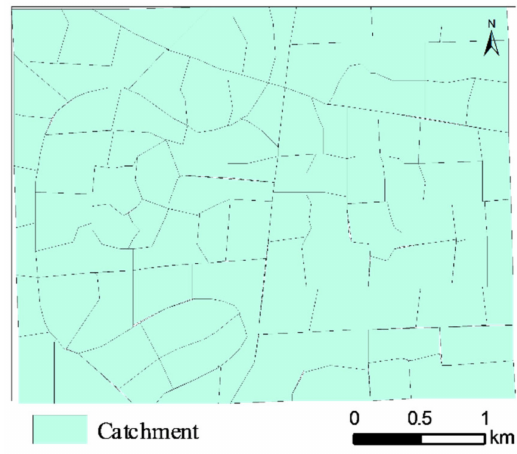
Figure 4. Catchment division